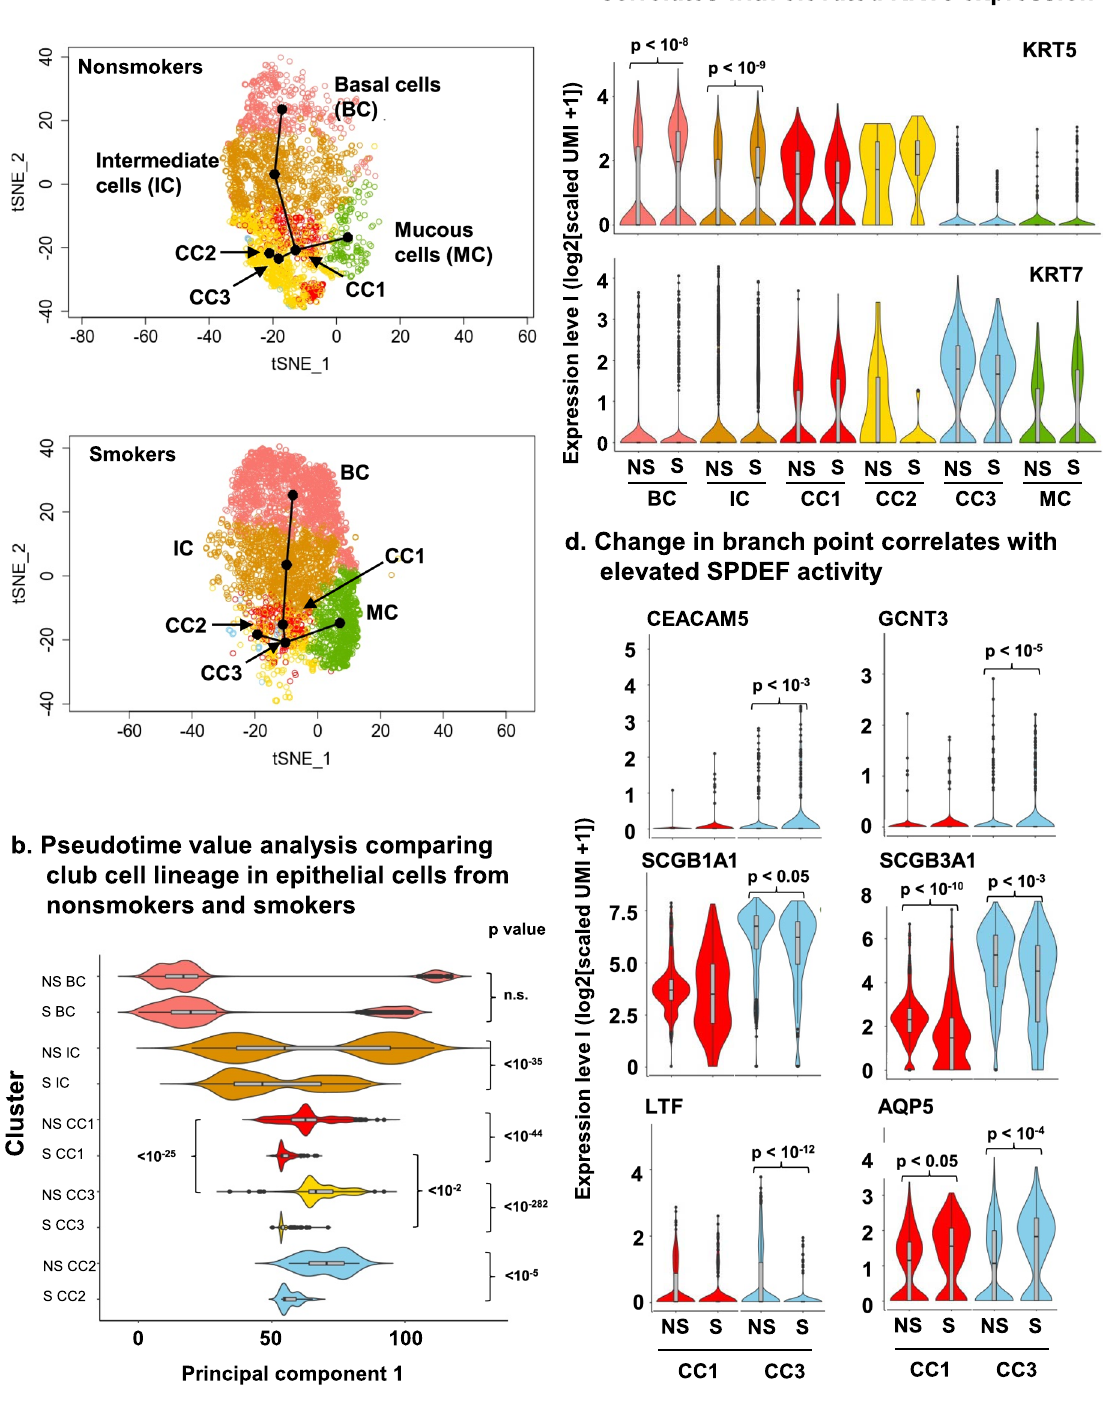
(Fig. 6a). As a fraction of the overall club cells, subcluster 3 effector club cells represented a smaller fraction of the total population in smokers compared with nonsmokers (Fig. 6b). Together, the data indicate that smokers have fewer overall club cells and that